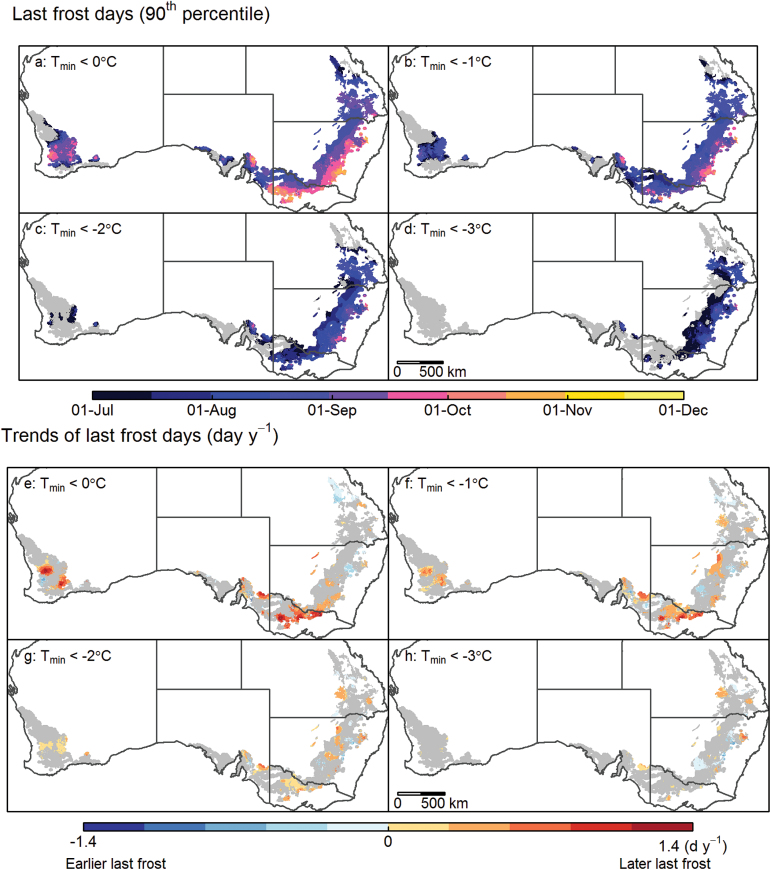
Maps of the last frost day of the year (90th percentile; a–d) and the temporal trend of last frost day (e–h) for minimum temperature (T
min) thresholds of 0 °C (a and e), –1 °C (b and f), –2 °C (c and e), and –3 °C (d and h) across the Australian wheatbelt. The grey shading in (a–d) indicates ‘frost-free’ regions where ‘frost’ events at the specified temperature threshold occurred in <10% of years, and in (e–h) regions where trends in last frost days were not significant (P>0.1) or for which there were <10% years with frost. Data correspond to the last frost day over 57 years (1957–2013).